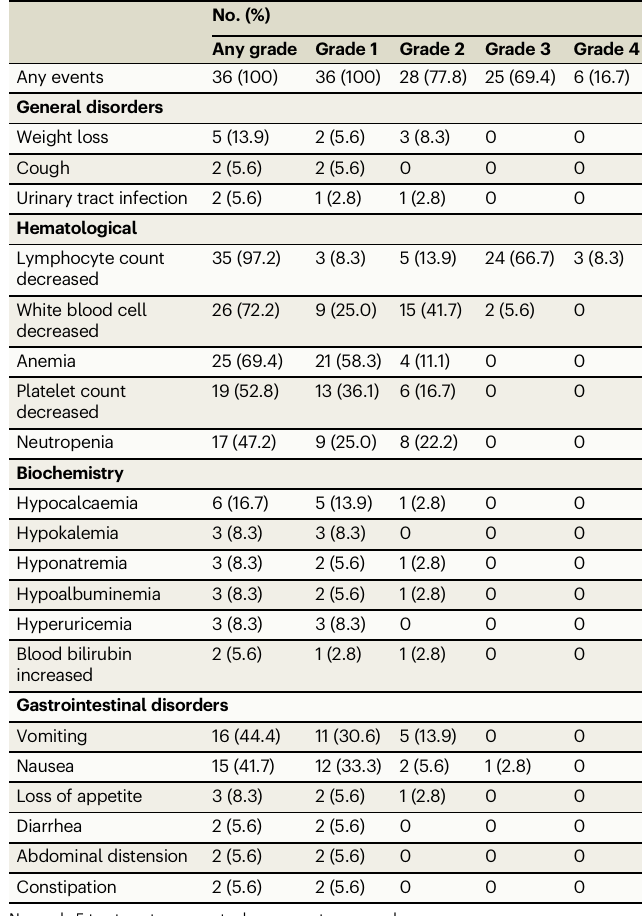
Table 3 | Treatment-emergent adverse events occurring in 5% or more of patients ( N = 36) No. (%)